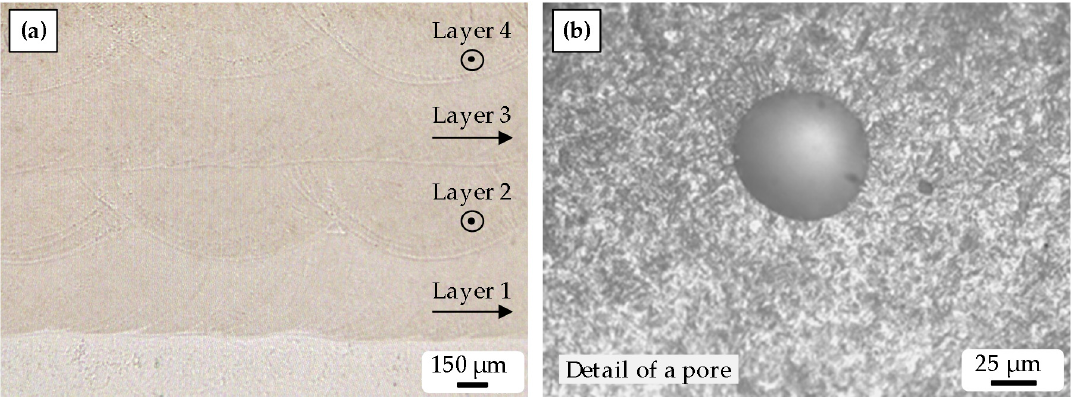
Figure 5. Metallography of the ( a ) deposited layers; ( b ) detail of a pore.